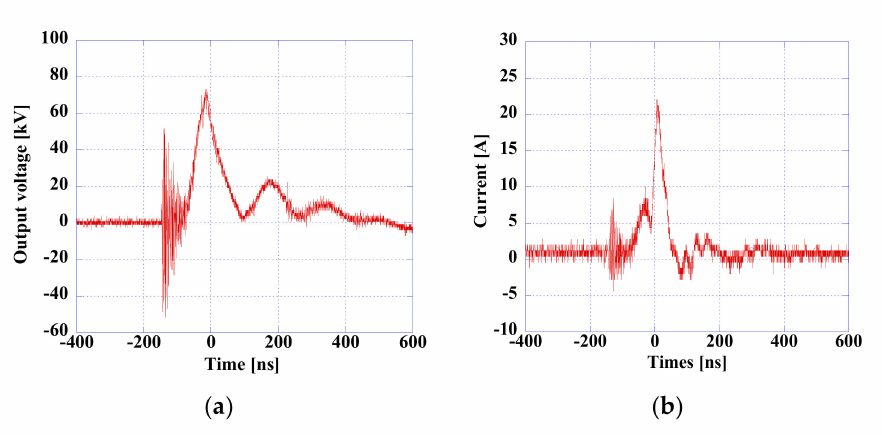
Figure 4. Typical applied waveforms to the petri dish (charging voltage: 10.5 kV); ( a ) voltage waveform; ( b ) current